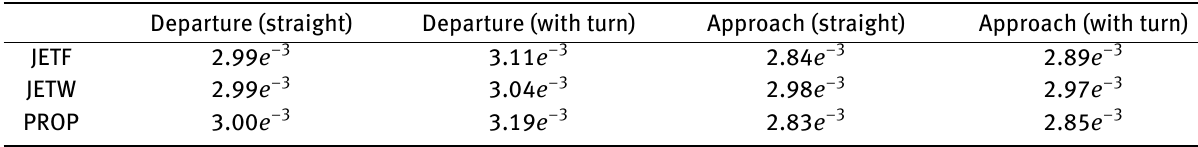
Table 1: Results of the validation of a novel implementation for a baseline estimation method wrt. ECAC reference. Values in dB. All values are below 0.01 dB accuracy